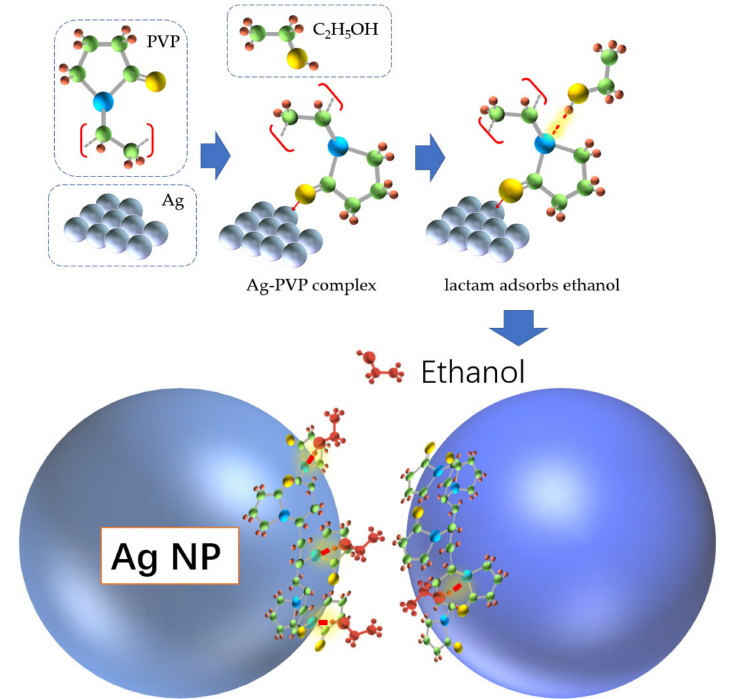
Figure 9. In the preparation of Ag NPs, Ag atoms grew into Ag NPs on PVP templates [28]. After freeze-drying, PVP molecules were retained and attached to Ag NPs. Ethanol molecules are trapped on the surface of Ag NPs by hydrogen bonding from the lactam group of PVP. When the PVP located in the gap between the two Ag NPs captures the ethanol, the Raman light intensity is enhanced by local electric field.